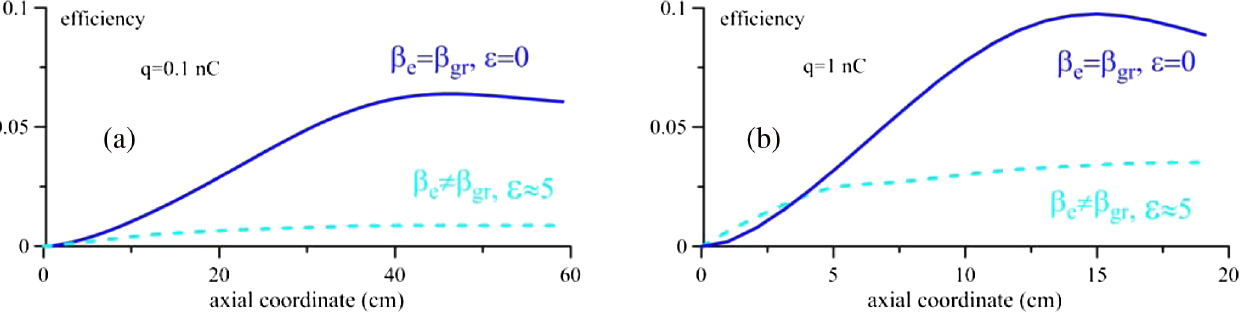
¼ λ = 4 ) bunches with two different bunch charges 0.1 (a) and 1 nC (b). Efficiency of the FIG. 9. Spontaneous emission from short ( L e; 0 electron-wave interaction versus the axial coordinate. Solid curves describe the regime of the exact group resonance, and dashed curves illustrate a case when the group wave velocity is smaller than the bunch